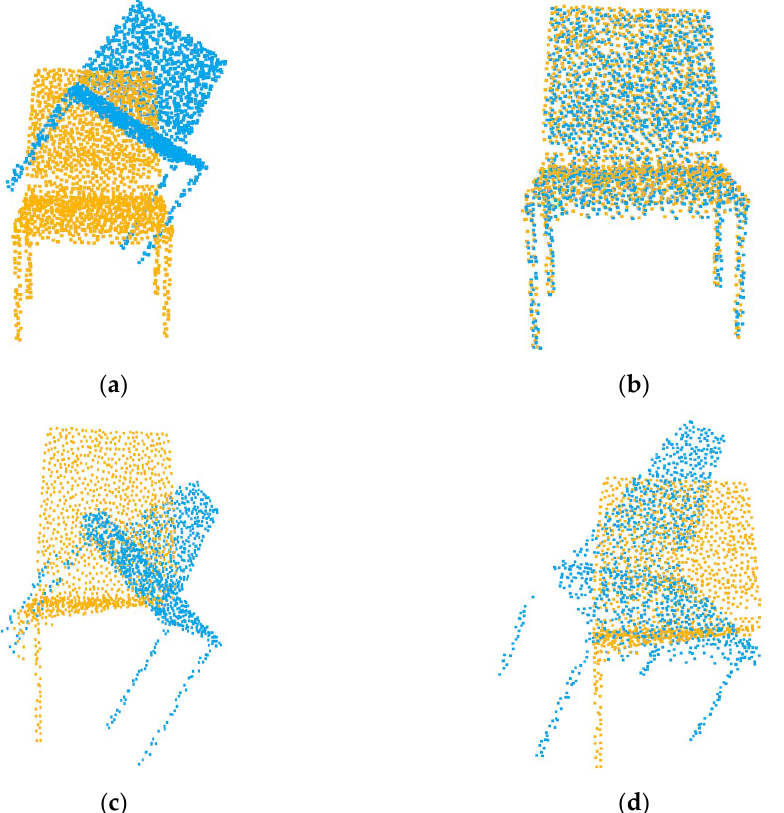
Figure 4. Registration results of PointNetLK with different inputs. ( a ) The fully overlapping point